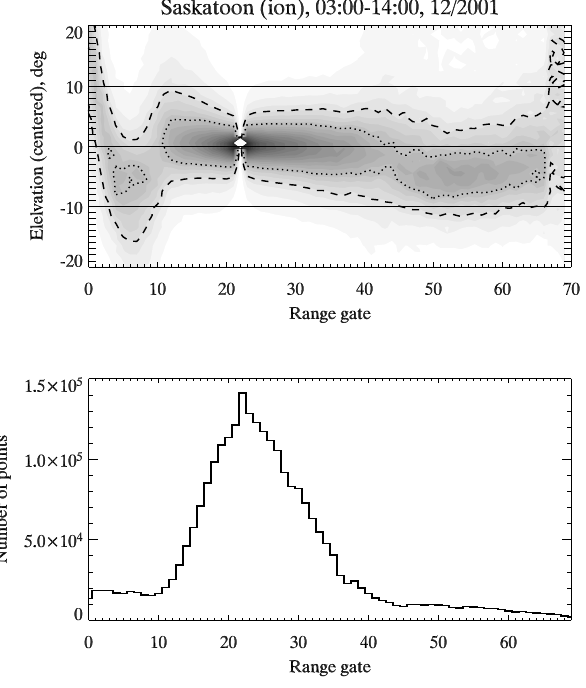
Fig. 12. Simulated velocity distortion magnitudes without (top panel) and with (bottom panel) correction for a non-unity refractive index based on n(h mF ) for a range of ratios f cF /f 0 . Repeatable range patterns correspond to consecutive hops (up to 3.5-hop mode for f cF /f 0 ≥ 0 .